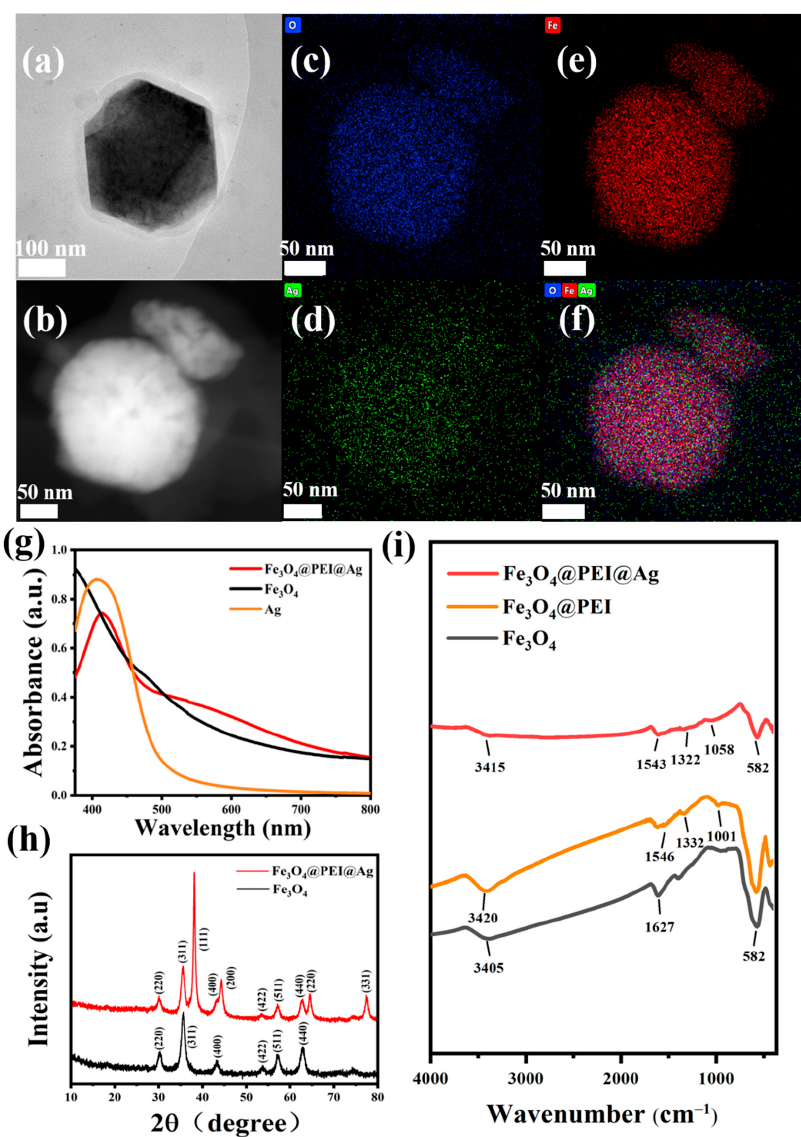
Figure 1. The characterization of the synthesized Fe 3 O 4 @PEI@Ag structure: ( a ) the TEM images of Fe 3 O 4 @PEI@Ag structure; ( b ) the dark field TEM image and ( c – f ) the elemental mapping images of Fe, O, Ag composition, respectively; ( g ) UV-vis absorbance spectra of each Fe 3 O 4 , Ag, and Fe 3 O 4 @PEI@Ag structure, in DI water medium; ( h ) powder XRD patterns of Fe 3 O 4 and